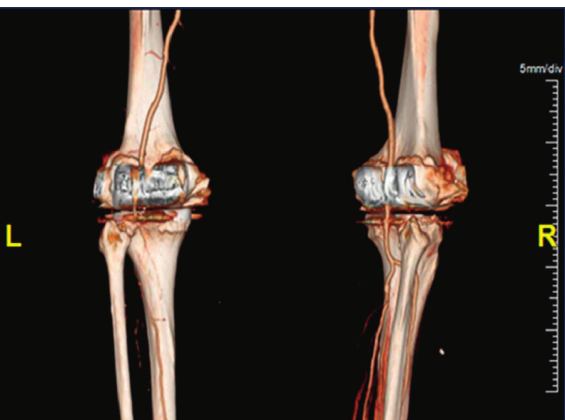
Figure 3: Computed tomography (CT) angiography. This CT image revealed left popliteal, left deep femoral, and left anterior tibial artery occlusion.